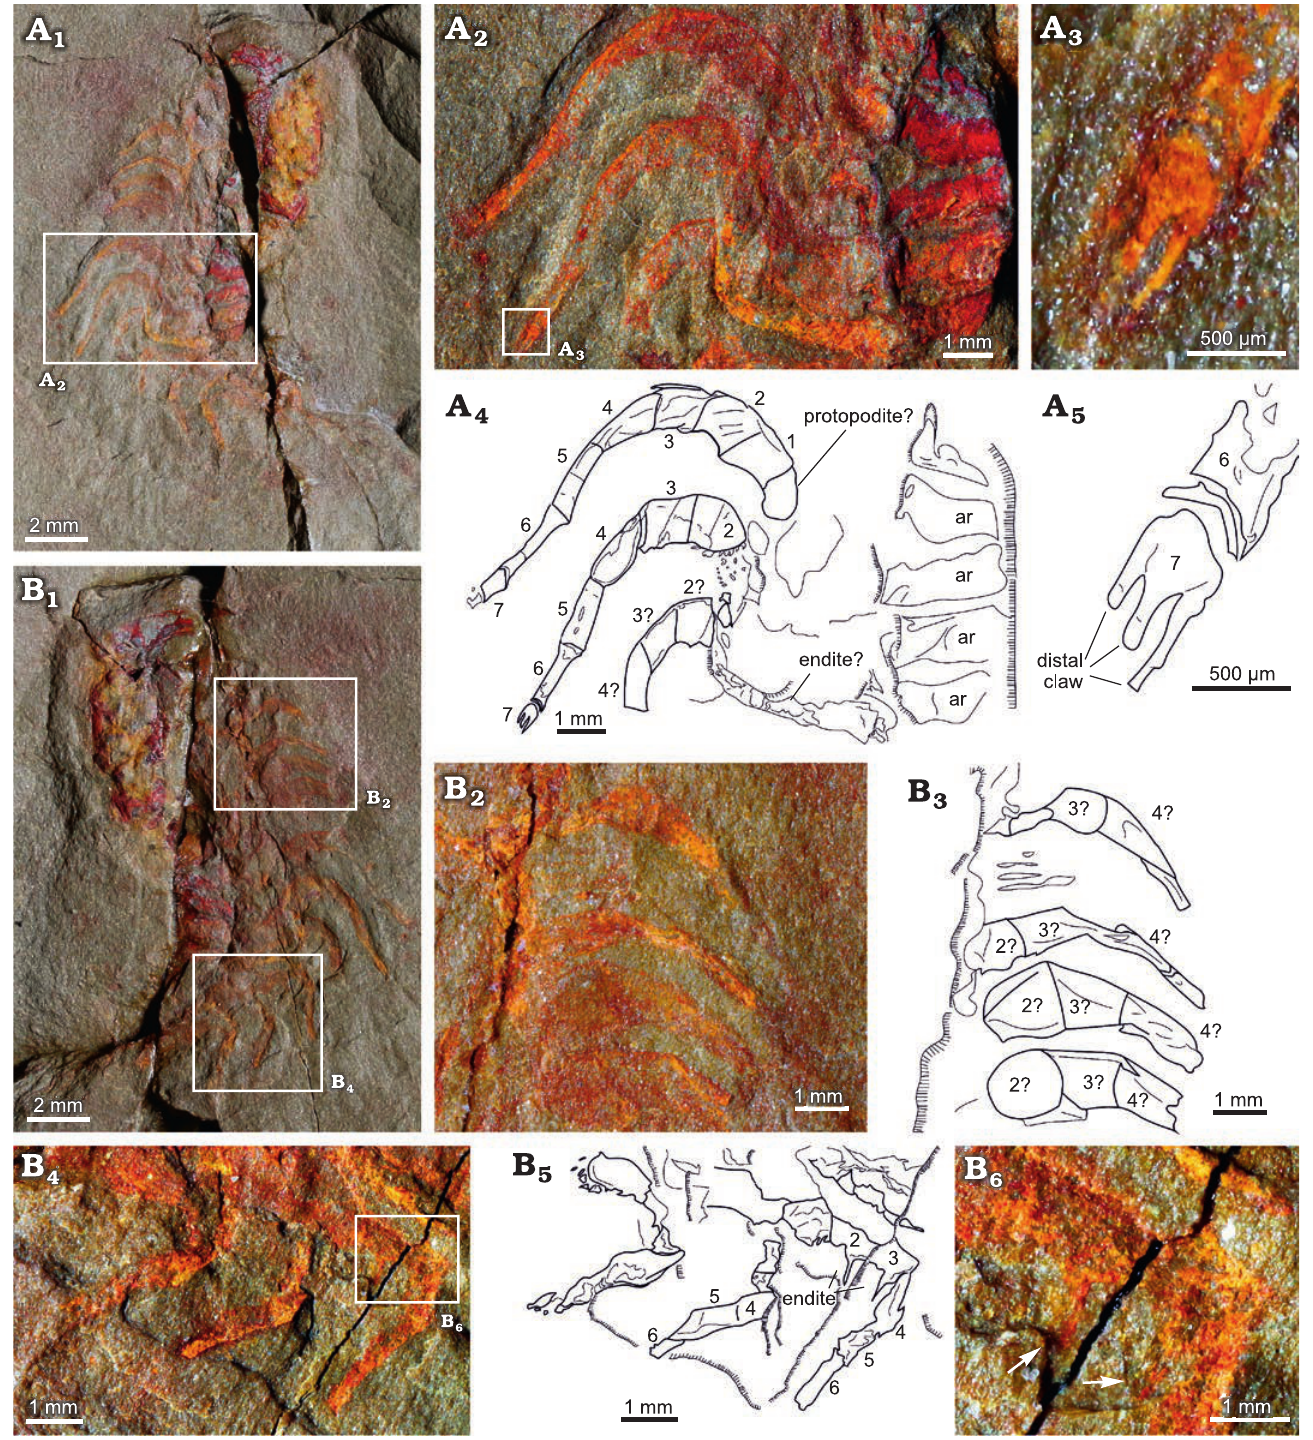
Fig. 5. Endopodites of the cheirurid trilobite Anacheirurus adserai (Vela and Corbacho, 2007) from the Fezouata Shale, Araneograptus murrayi Zone, Tremadocian, Lower Ordovician, near Beni Zouli, Zagora Province, Morocco. A . Part of YPM 226573, general view (A 1 ), close-up of the endopodites (A 2 ) and explanatory drawing (A 4 ), close-up of the distal claw (A 3 ) and explanatory drawing (A 5 ). B . Counterpart of YPM 226573, general view (B 1 ), close up of the endopodites (B 2 ) and explanatory drawing (B 3 ), close up of the endopodites (B 4 ) and explanatory drawing (B 5 ), close up of the area pointed out in B 4 (B 6 ), arrows showing long endites on podomere 2 and 3. Numbers represent podomere number. Abbreviations: ar, axial